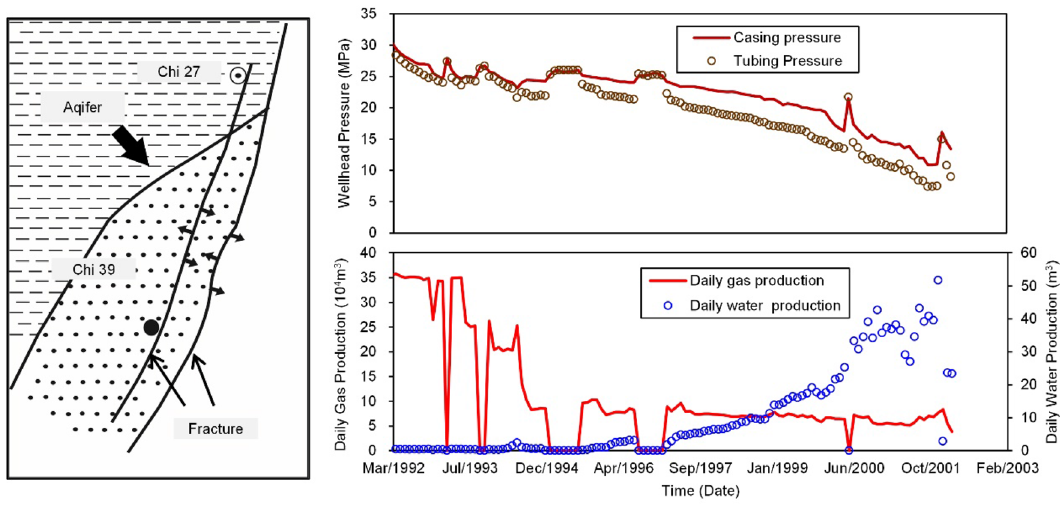
Figure 1. Schematic diagram and production history of Chi 27-39 well in the gas field in eastern Sichuan, China. Modified according to Gou et al. 27